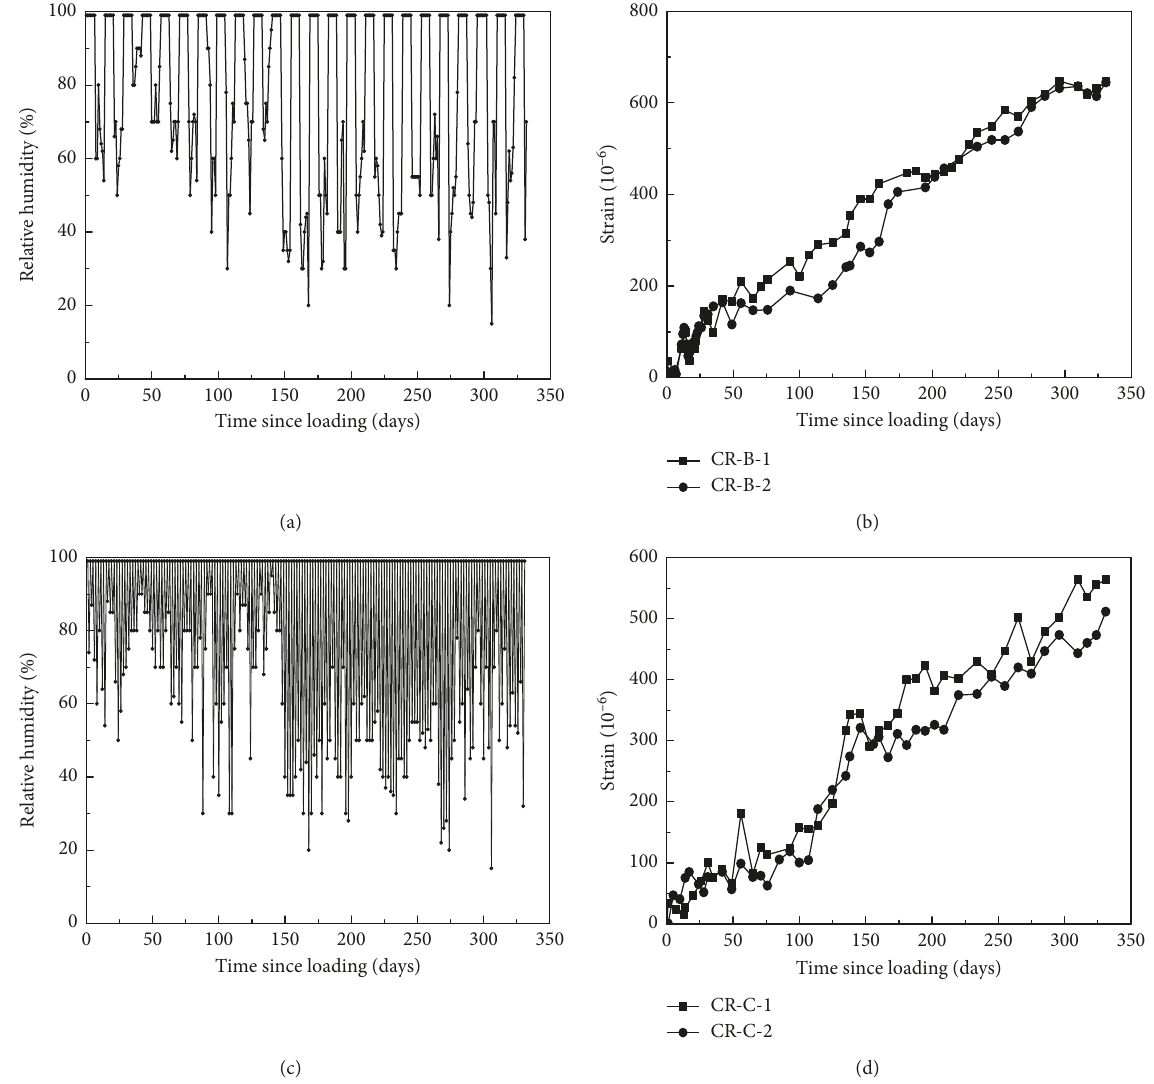
Figure 8: Humidity data and creep strain curves: (a) humidity (exposure condition 2); (b) creep strain curves for specimens CR-B-1 and CR- B-2; (c) humidity (exposure condition 3); (d) creep strain curves for specimens CR-C-1 and